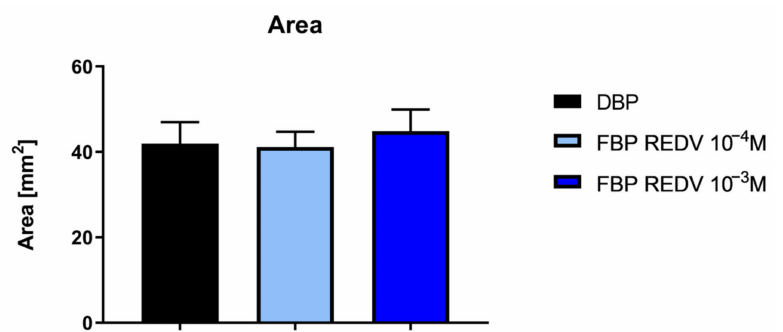
Figure 4. Measurement of the area of functionalized and not functionalized samples.